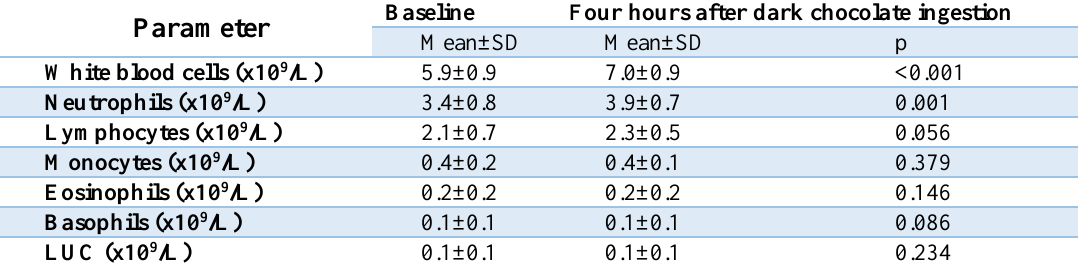
Table 1. White Blood Cell Count and Differential Count Four Hours after Dark Chocolate Ingestion in Eighteen Ostensibly Healthy